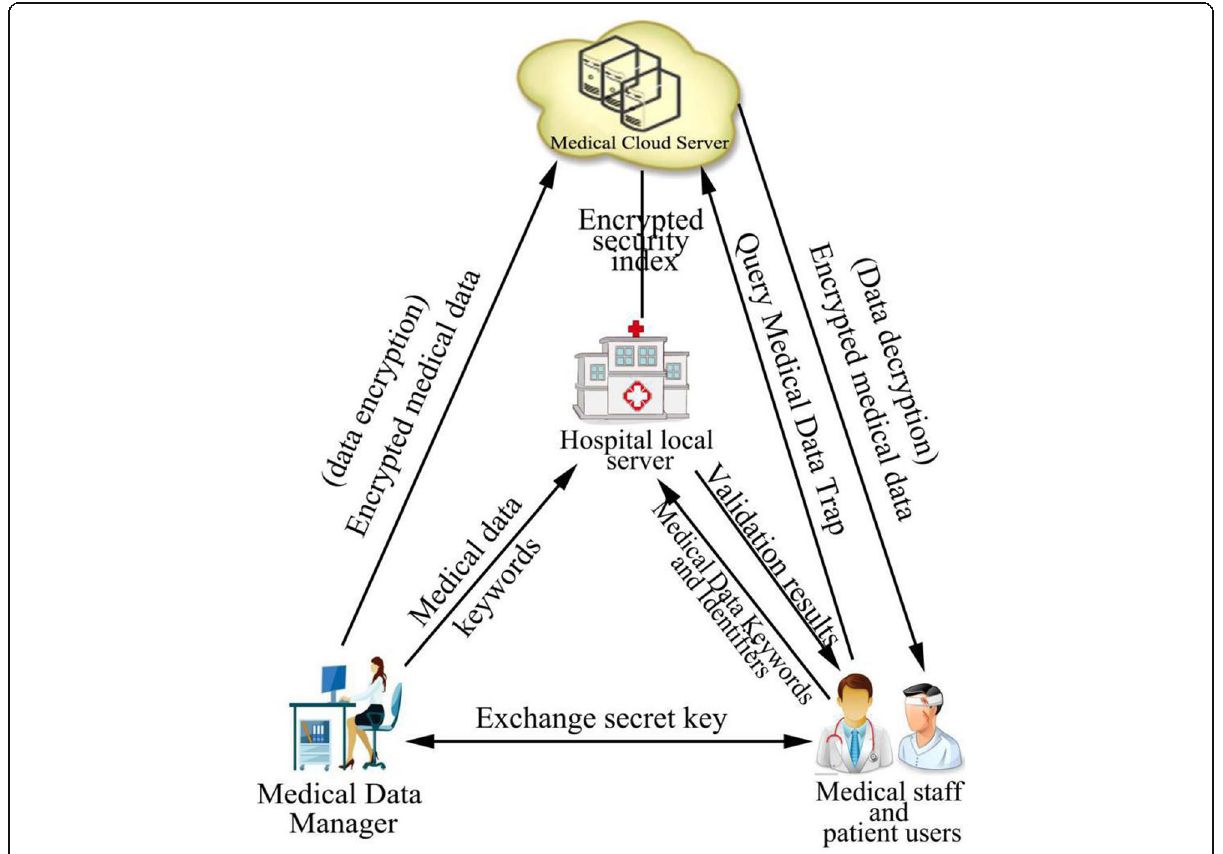
Fig. 10 Secure searchable encryption